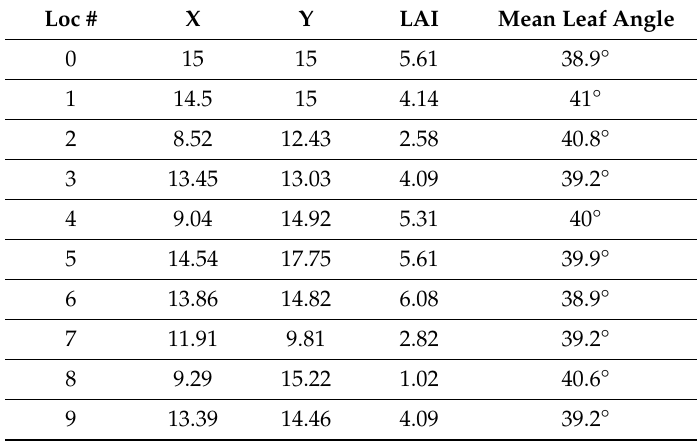
Figure 14. Heat map of LAI, left, and mean leaf angle, center, in one meter pixels. Blue scatter points are displayed on the heat maps for the lidar interrogation sites. Right, the cumulative distribution function curves for the 10 interrogation sites are plotted over each other, along with planophile and spherical distribution curves for reference. Table 5. List of interrogation locations in x, y coordinates, LAI, and mean leaf